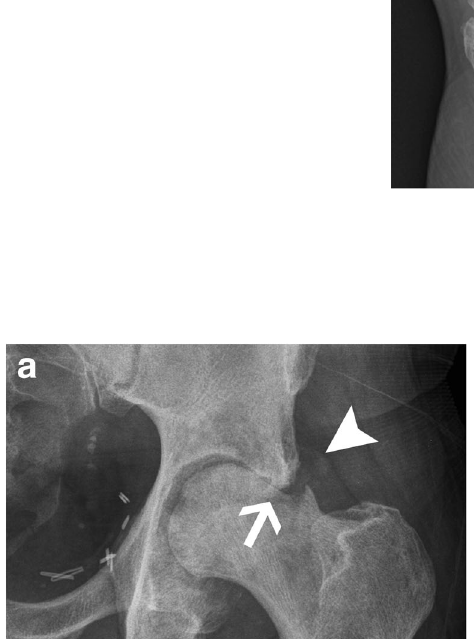
Fig. 12 Periarticular calcifications following corticoid injection. ( a ) Frontal, ( b ) oblique and ( c ) lateral radiographs of the wrist show palmar soft tissue calcifications (arrowhead) following carpal tunnel injection of